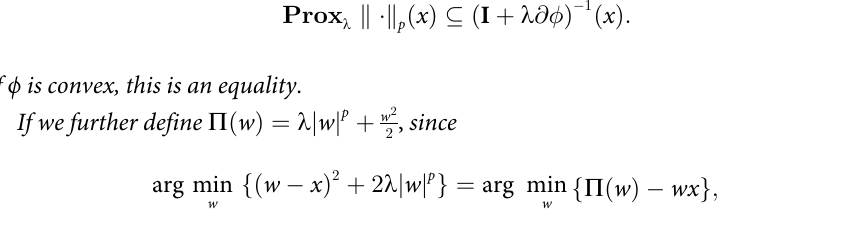
Table 9. Average denoising results of different algorithms for Poisson-Gaussian noise. Image Peak σ n